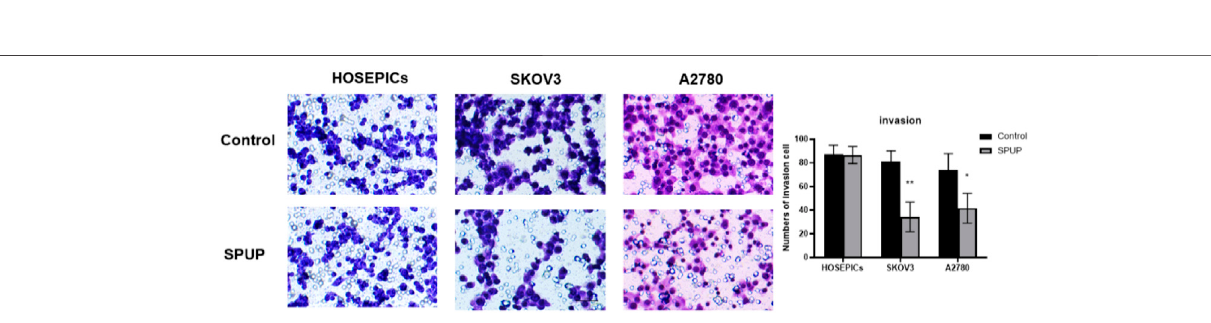
Frontiers in Materials |